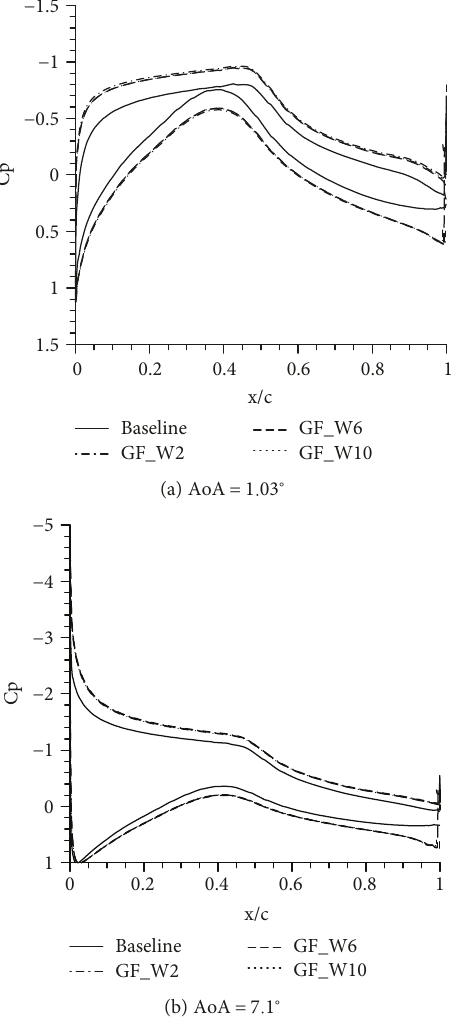
Figure 7: Pressure coe ffi cient distribution comparison of the airfoil with di ff erent Gurney fl ap widths.